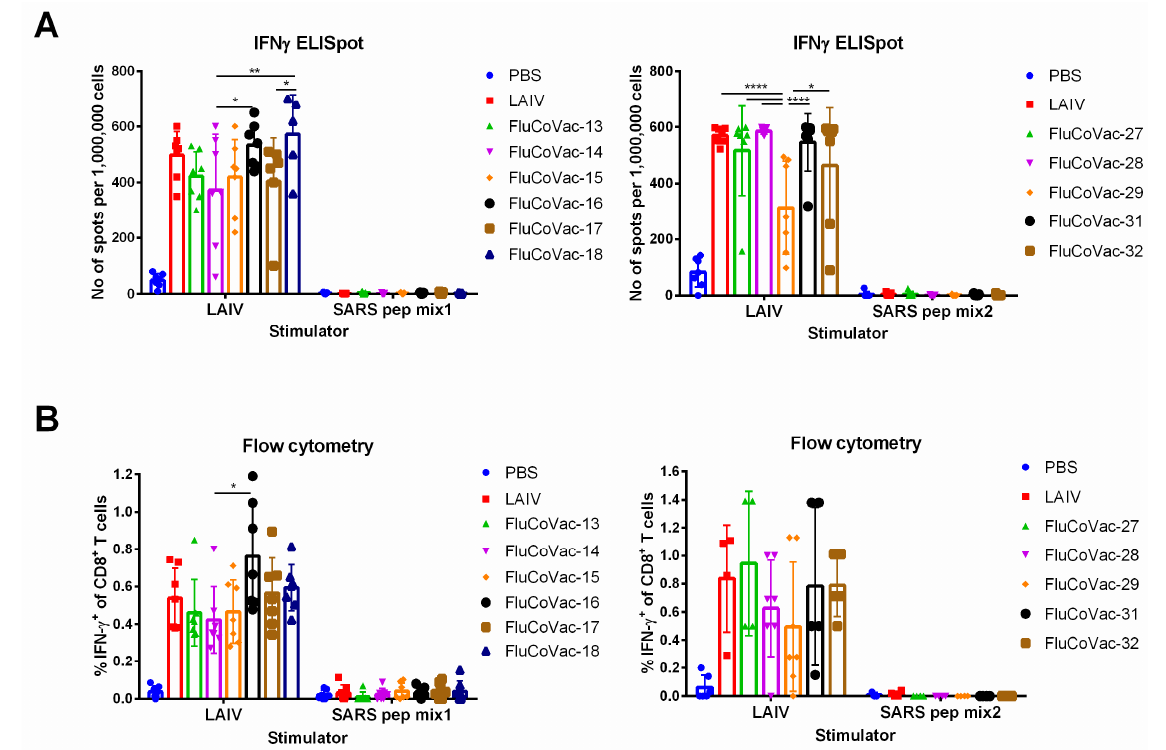
Figure 4. Virus-specific cellular immune responses in HLA-A2.1 mice. Transgenic mice were i.n. inoculated twice with 10 6 EID 50 of each test virus within a 3-week interval. On day 10 post second dose mouse splenocytes were collected and virus-specific cellular responses were assessed by ( A ) ELISpot analysis or ( B ) ICS after stimulation with whole influenza virus or a mixture of SARS-CoV-2 peptides. Data were analyzed by two-way ANOVA with Tukey’s post-hoc multiple analyses test. *— p < 0.05; **— p < 0.01; ****— p < 0.0001.